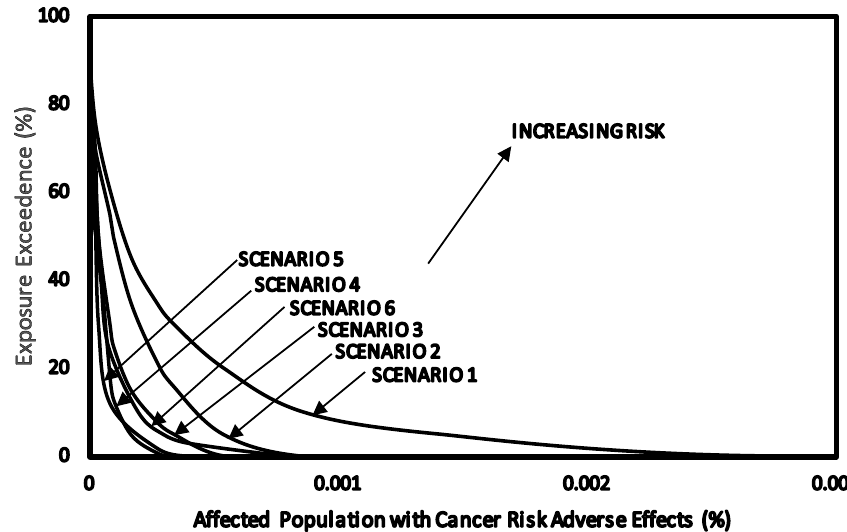
Figure 8. Overall risk probability for cancer as a result of exposure to benzene concentrations in air of service station